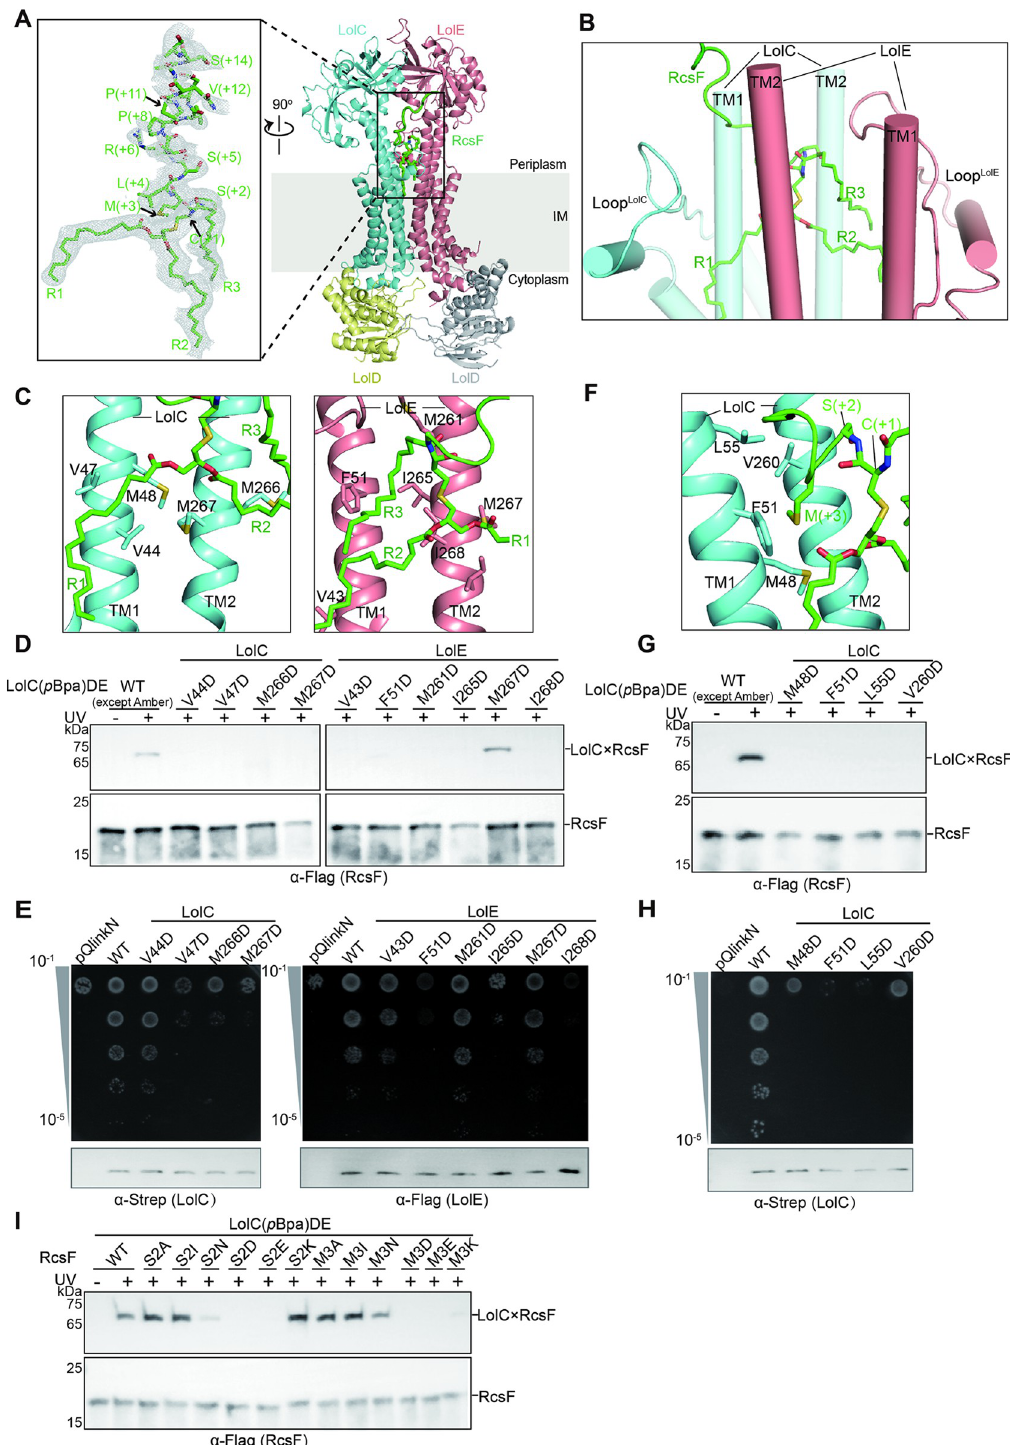
Fig 3. The bipartite binding mode between RcsF and LolCDE. ( A ) Ribbon diagram of RcsF-LolCDE structure (right). Zoom-in view of the atomic model of RcsF superimposed with the cryo-EM densities (left). The arrow indicates the +1 position of the mature RcsF. The 3 acyl chains (R1, R2, and R3) and the N-terminal 14 residues of the proteinaceous portion are labelled. ( B ) Side view of the V-shaped cavity and the RcsF-binding mode. TM segments are shown in cylindrical helices. ( C ) Zoom-in view of the hydrophobic interactions between acyl chains (R1, R2, and R3) and LolC (left) or LolE